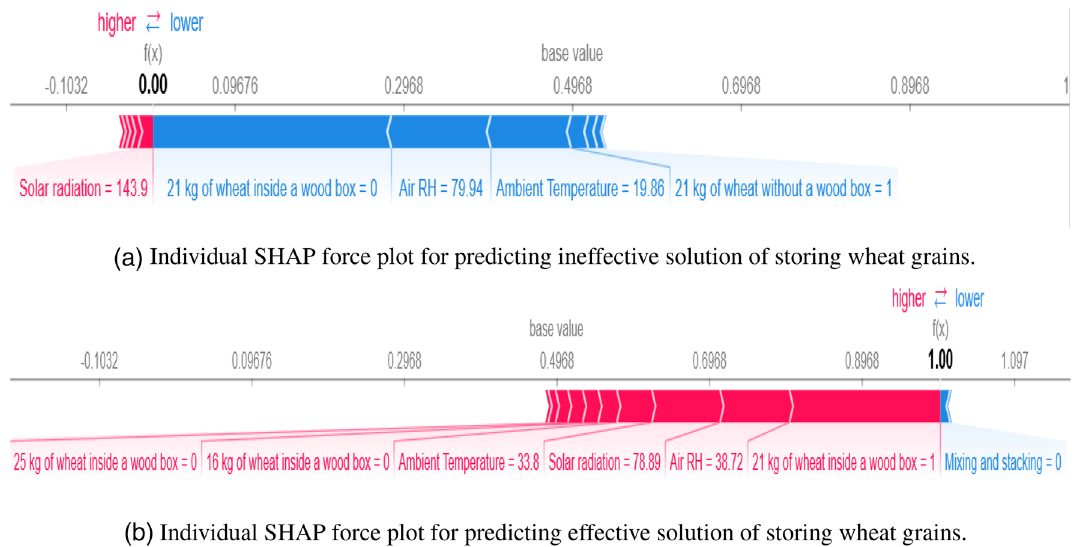
Figure 6. Illustration of SHAP force plots for ineffective ( a ) and effective ( b ) predicted solutions of storing wheat